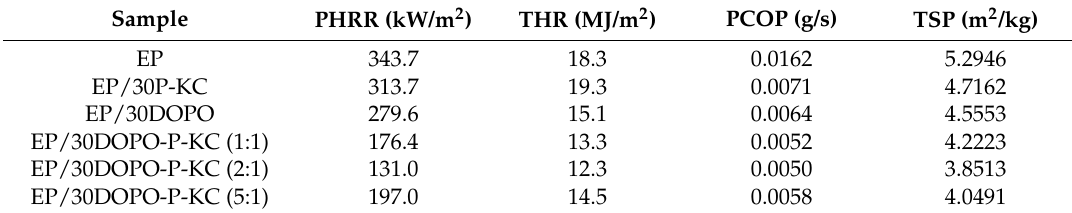
Figure 6. Heat release rate (HRR) curves of the pure waterborne epoxy (EP) and FR-EP. Table 5. Cone calorimetry data for the pure EP and